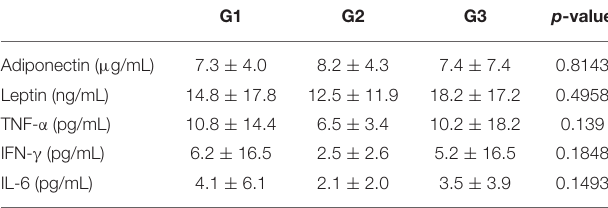
TABLE 5 | Serum levels of adipocytokines and cytokines in women stratified by the group of people living with HIV/AIDS with (G1) and without HALS (G2) and control group